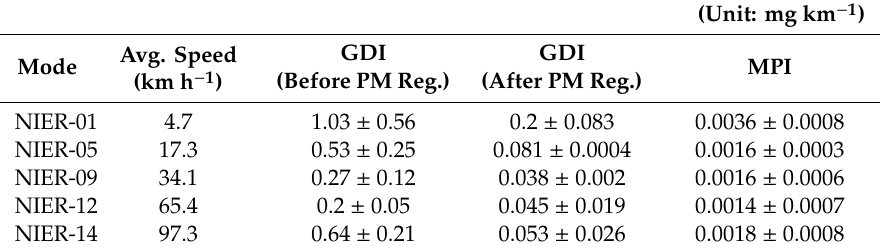
Table 4. BC Emission from gasoline vehicles with di ff erent types of engines and PM regulations in the NIER